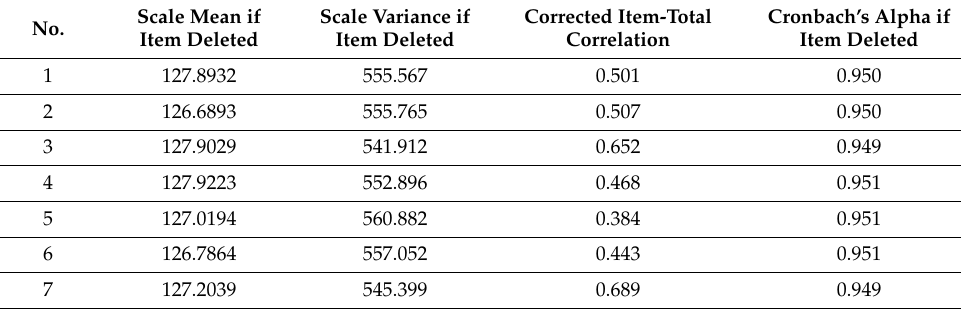
Table 4. Item-total